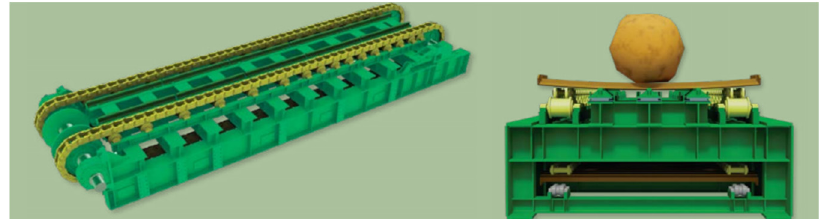
Figure 6. Mobility and impact methods of the feeding system [25].